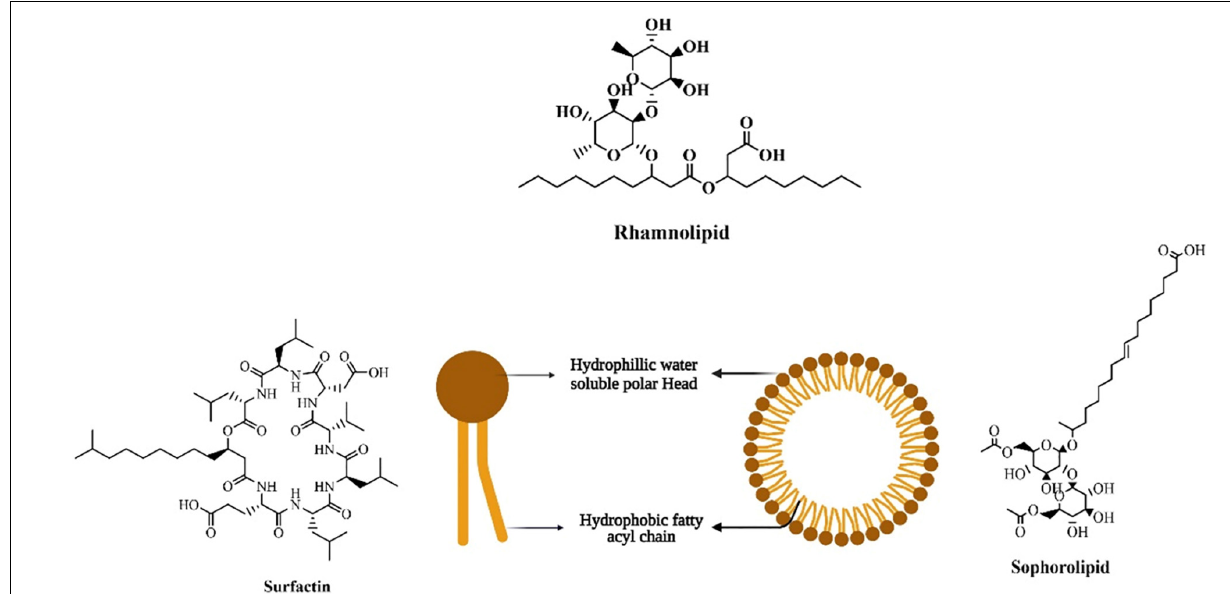
FIGURE 3 | Structure of biosurfactant.